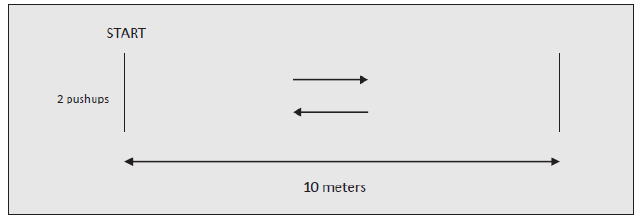
Figure 1. Specific endurance judo test